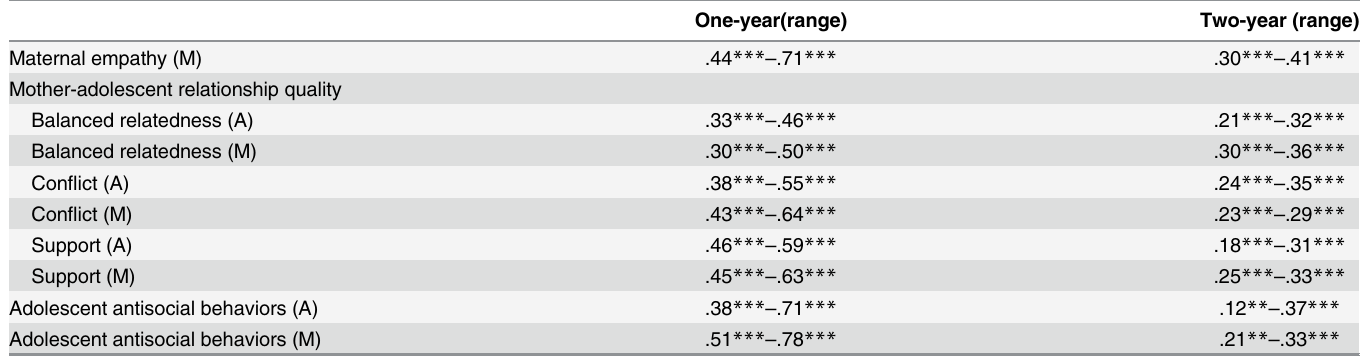
Table 4. One-Year and Two-Year Standardized Stability Paths for Study